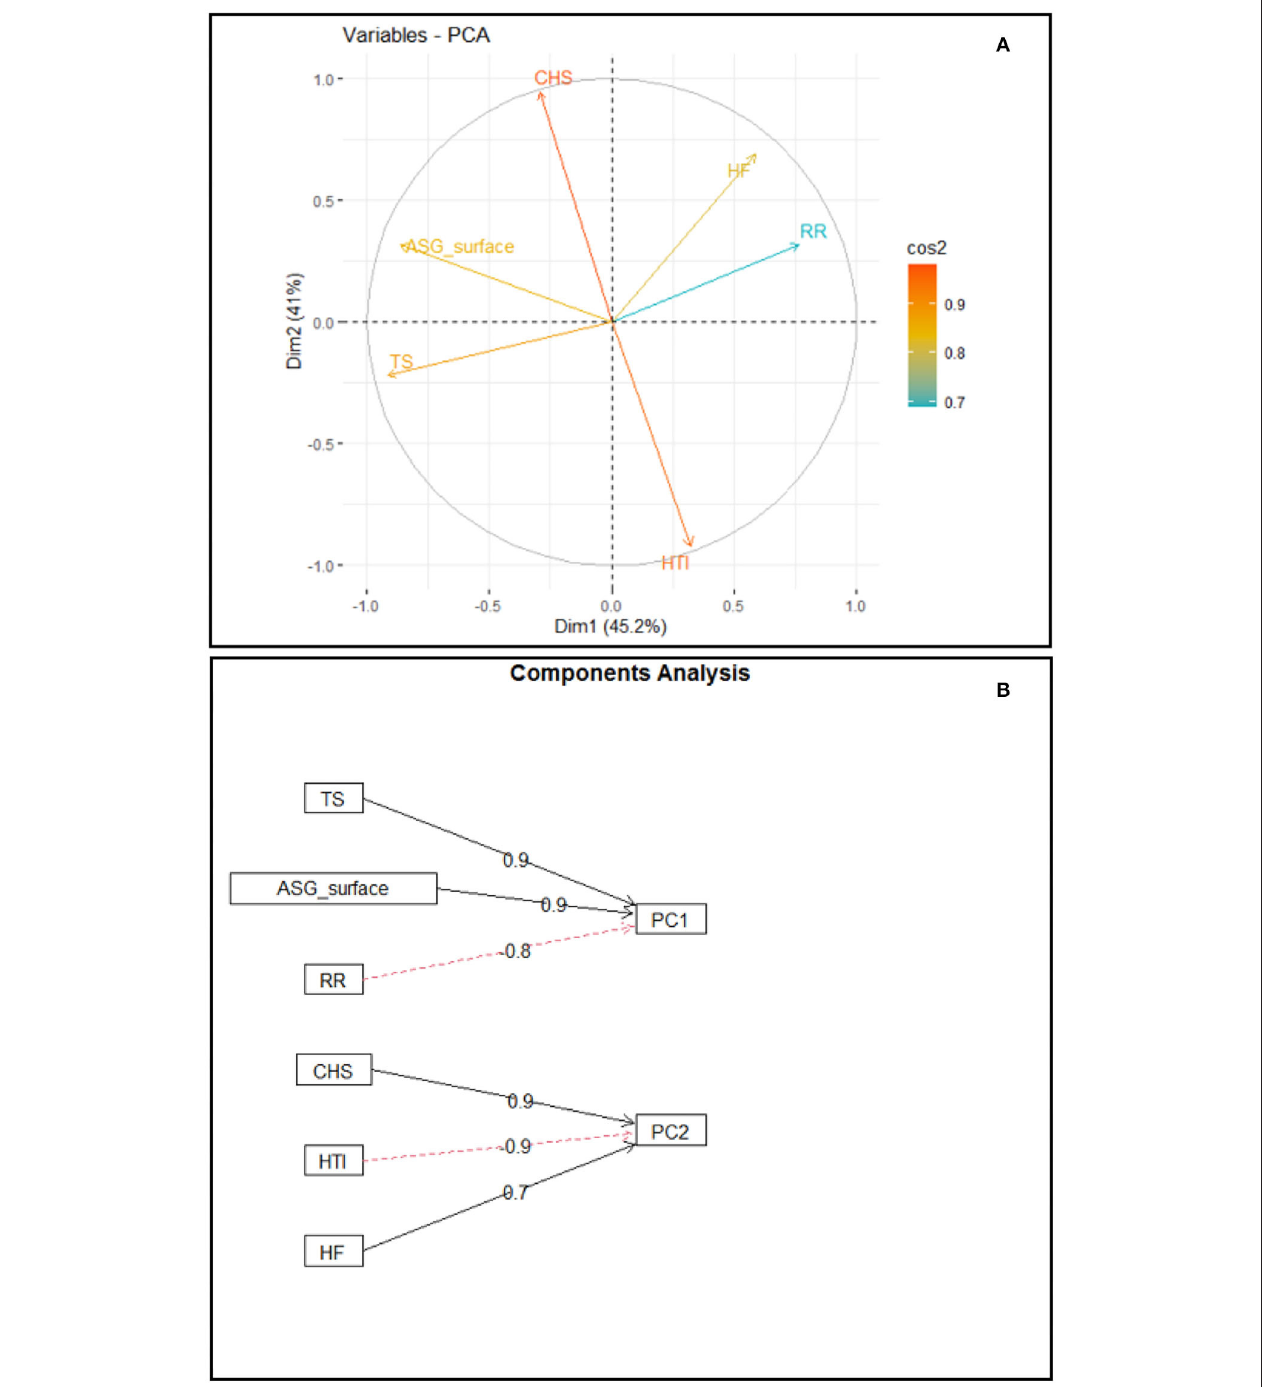
FIGURE 4 | Biplot of PC1 × PC2, indicating the contribution of the variables in the dimensions (A) ; Weight of the contribution of variables TS, ASG_surface, and RR to PC1 and weight of the contribution of variables CHS, HTI, and number of HF to PC2 (B) . first time, the morphometry of sweat glands and sebaceous